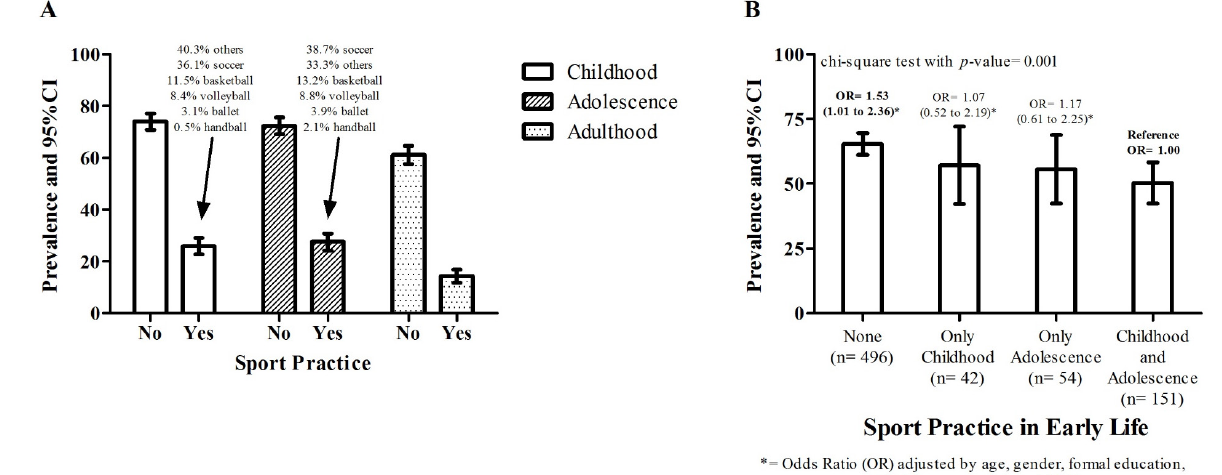
Figure 1. Sports practice throughout life ( Panel A ) and association between sports practice in early life and adulthood ( Panel B